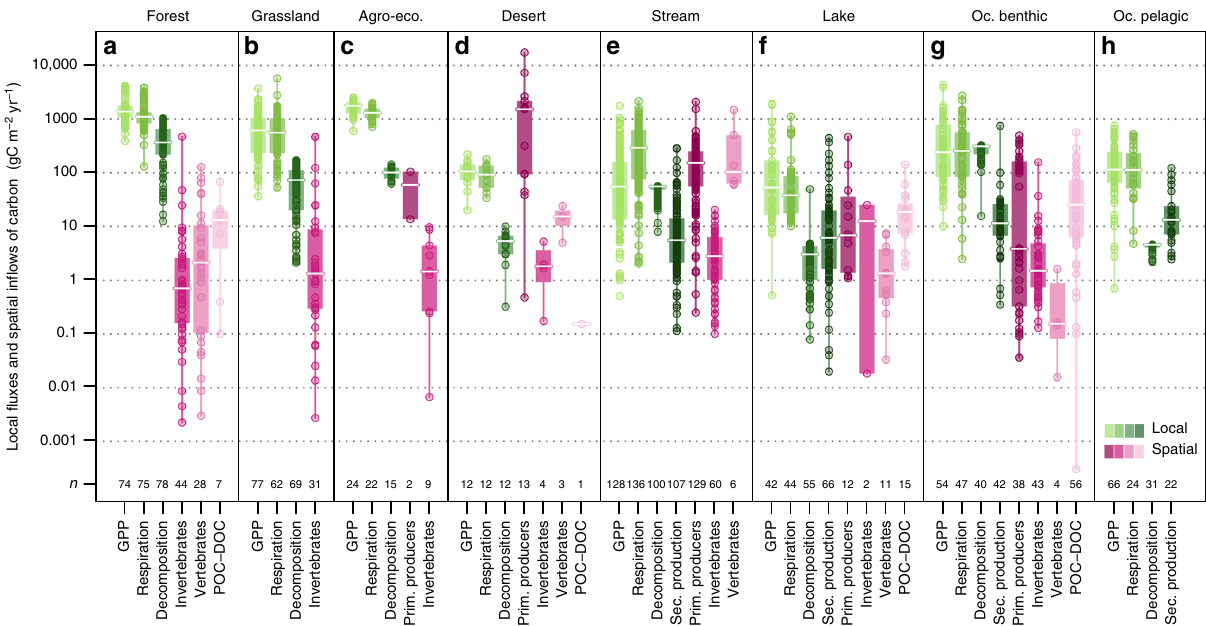
Fig. 3 Comparison of local fl uxes versus cross-ecosystem spatial in fl ows of carbon. Local fl uxes within (green), and cross-ecosystem fl ows to (pink), speci fi c ecosystem types ( a – h ). Panel titles give the ecosystem type (Oc. = Ocean). Local fl uxes depicted are gross primary production (GPP), ecosystem respiration, decomposition fl ux, and secondary production (in aquatic ecosystems only). Cross-ecosystem fl ows are clumped into imported material of four origins: primary producers, invertebrates, vertebrates, and organic carbon (particulate and dissolved: POC-DOC). No spatial fl ow of carbon to pelagic ocean ecosystems with areal units was found. Circles give values in gC m − 2 year − 1 on a log scale, and n the number of data points. Boxplots give median (white line), 25 and 75% percentiles (box), and range (whiskers). Whiskers and three null values of GPP in streams are omitted due to log scale. Note that fl uxes of GPP, measured locally, may not be independent from cross-ecosystem fl ows, which might contribute to local